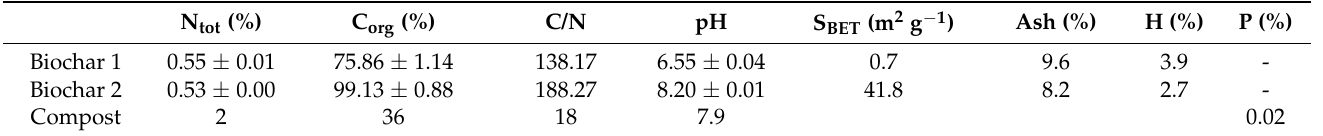
Table 1. The chemical properties of the biochar and compost in this